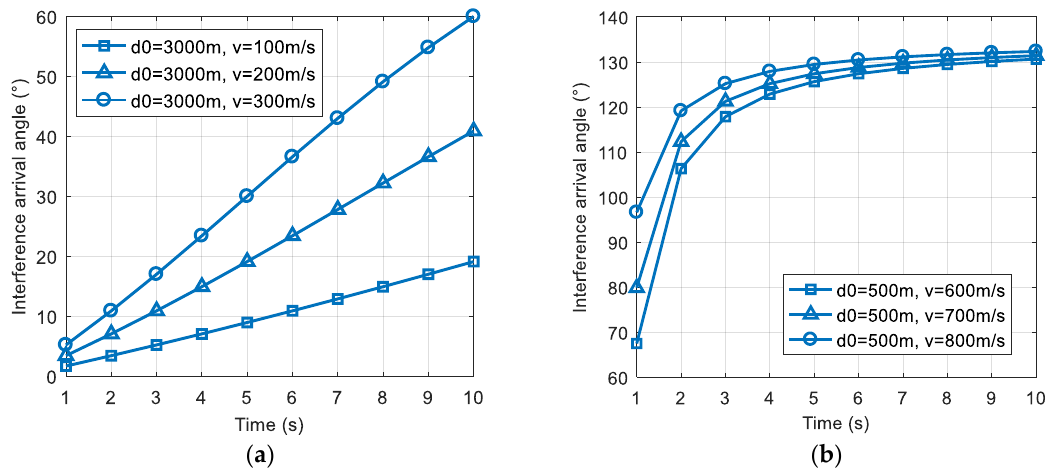
Figure 2. The change of the interference direction with the relative motion velocity v . ( a ) The change of the interference direction in the case where vt < d 0 ; ( b ) the change of the interference direction in the case where vt > d 0 .